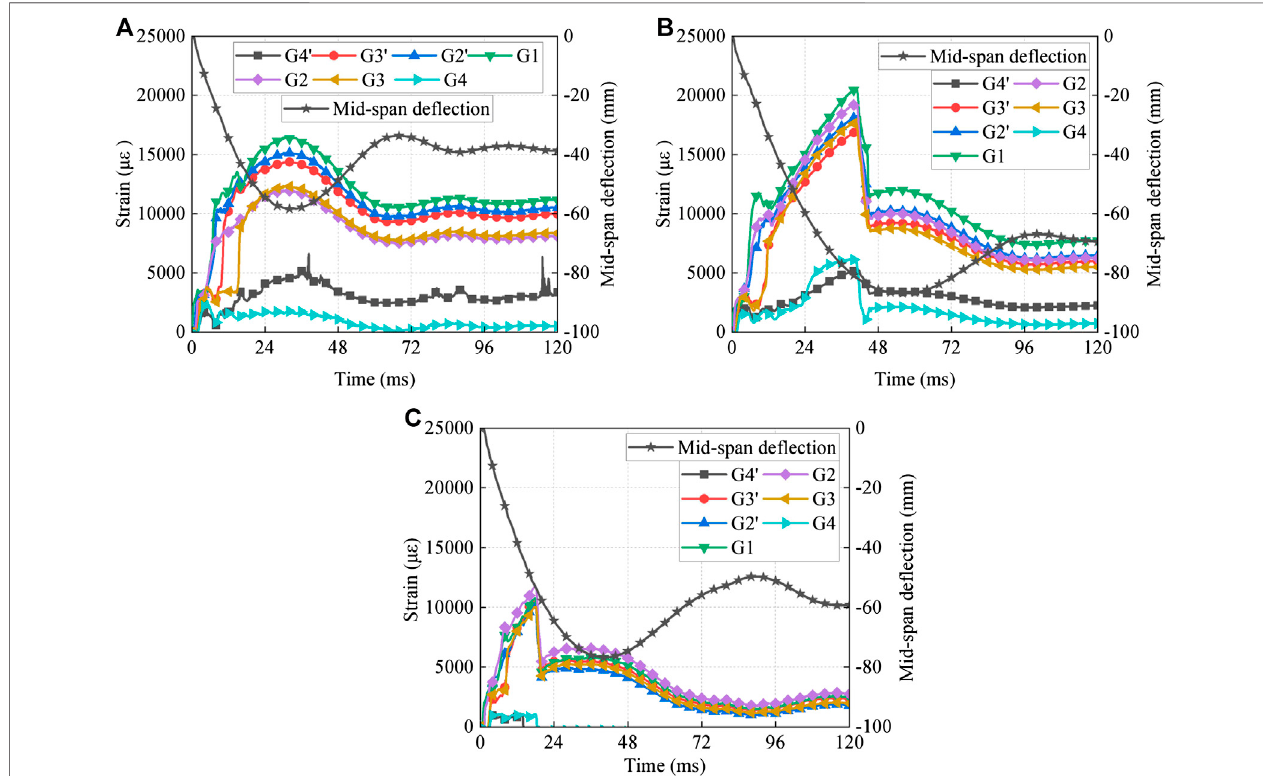
FIGURE 10 | Mid-span de fl ection and FRP strain histories. (A) AP-D1, (B) AP-D2, (C)